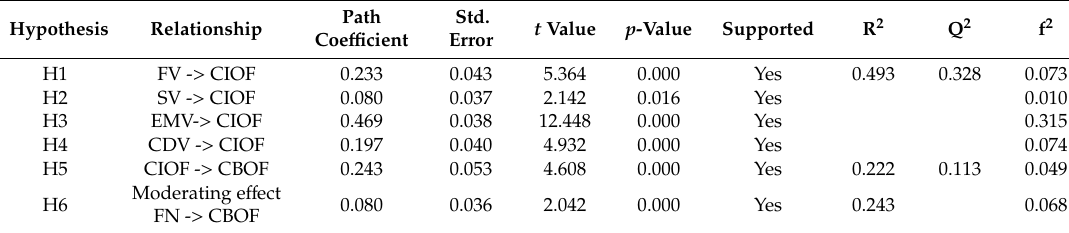
Table 4. Structural Model Results (Hypotheses testing).